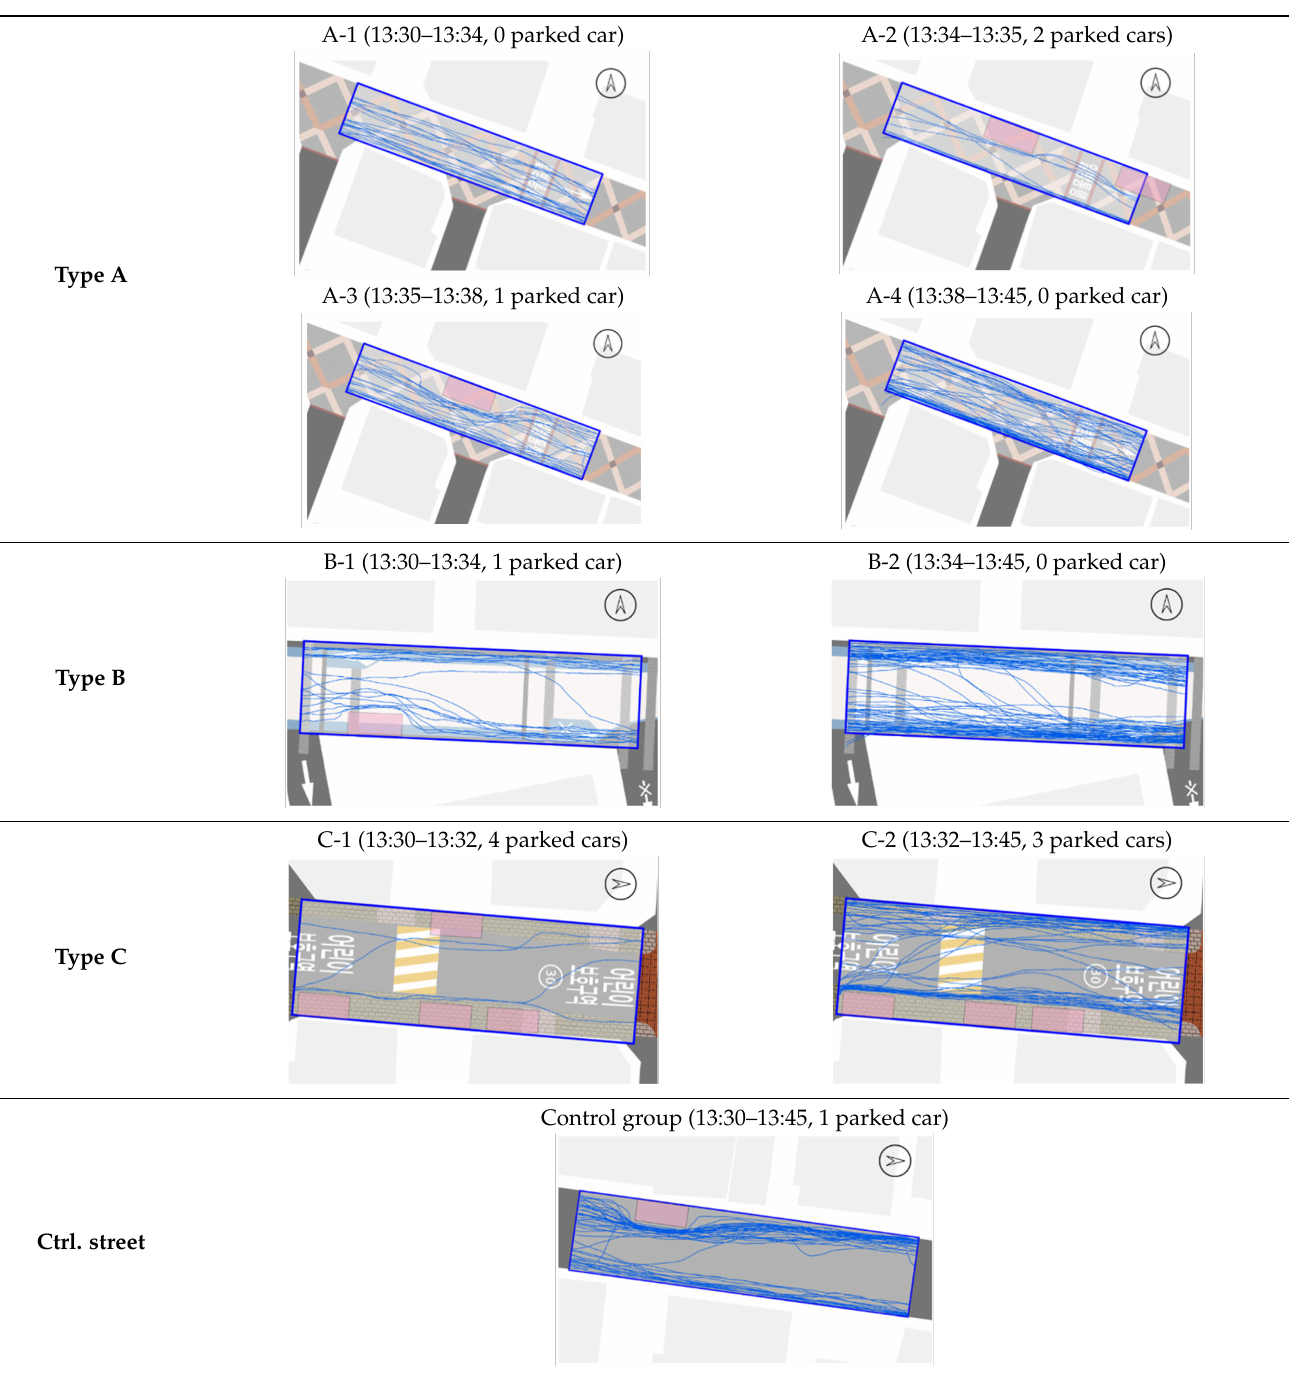
Table 7. Trace mapping results by design type and time slot (number of parked